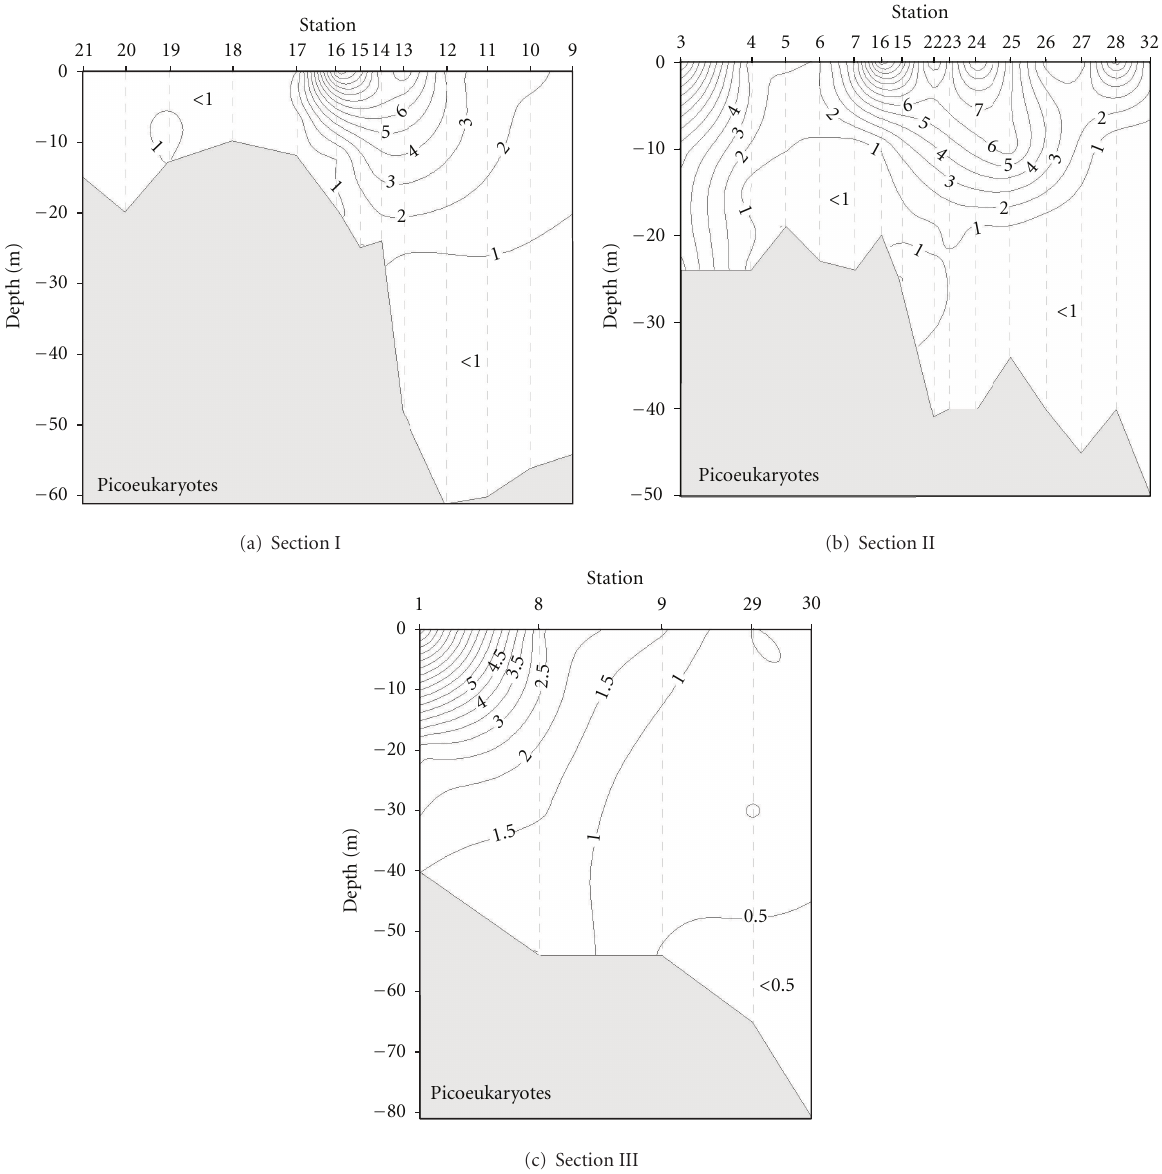
Figure 3: Spatial distribution of picoeukaryotes ( × 10 6 cells L − 1 ) in the Changjiang estuary and its adjacent sea area in June 2006.